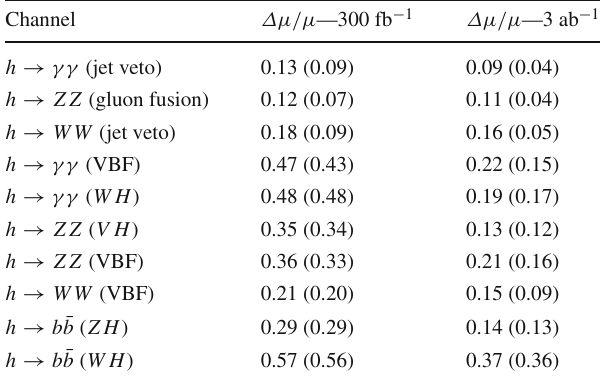
Table 3 Expected accuracy on the Higgs signal strength measure- ments for different luminosities and different channels, as extracted from Ref. [72]. From a study of the pp → h → γγ process (first block of the table), one can extract constraints on the ˜ c γ and ˜ c g parameters. The next four channels (second block of the table) provide informa- tion on the ˜ c γ , ˜ c g , ˜ c HB and ˜ c HW Wilson coefficients while all other processes (last block of the table) probe the ˜ c HB and ˜ c HW parameters